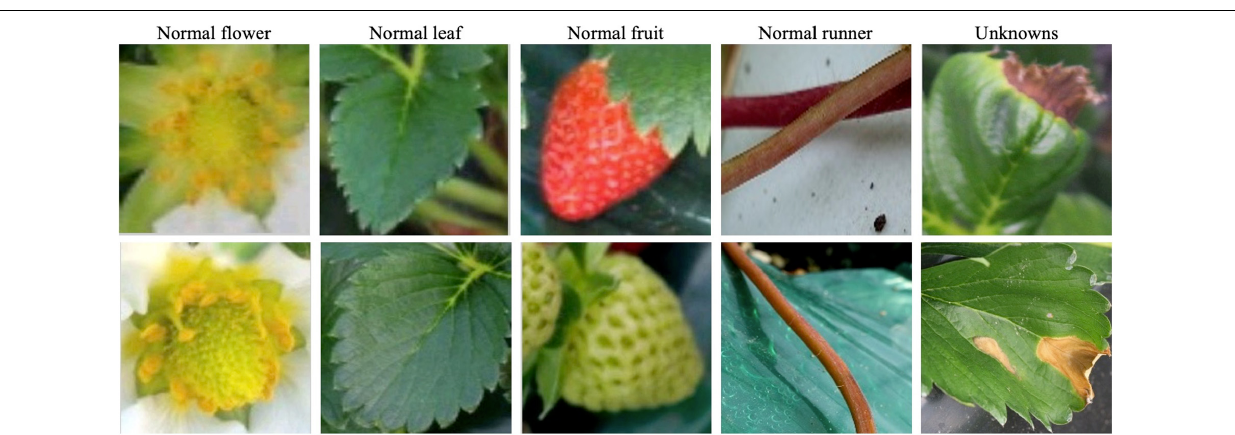
FIGURE 5 | Sample images for training disease detection.